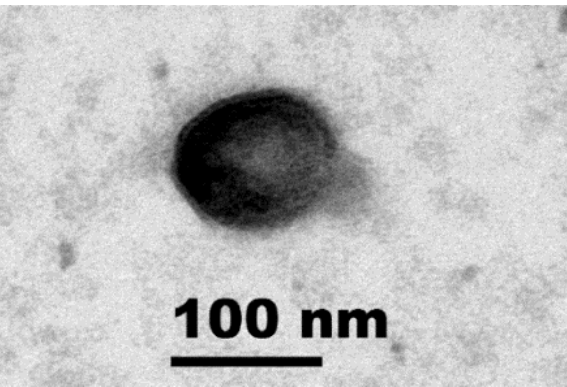
Figure 1. Morphology of cyanophage Mae-Yong924-1. Transmission electron micrograph of nega- tively stained phage particle. Scale bar, 100 nm.